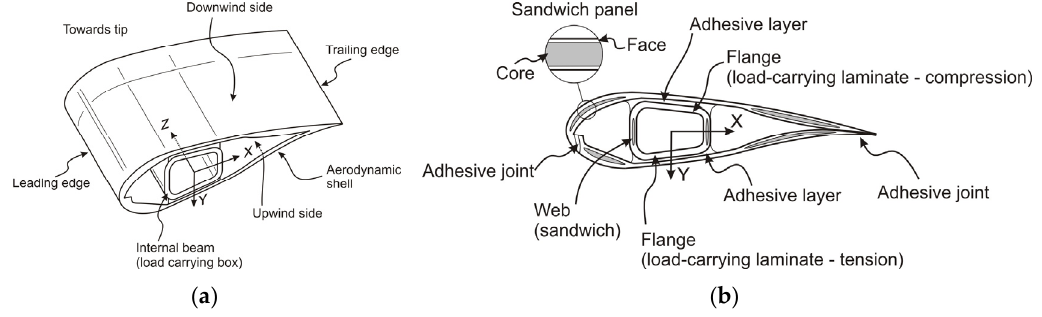
Figure 2. Blade design with a load-carrying box girder [23]. ( a ) The main elements of a wind turbine blade and ( b ) Nomenclature of the different blade construction elements.